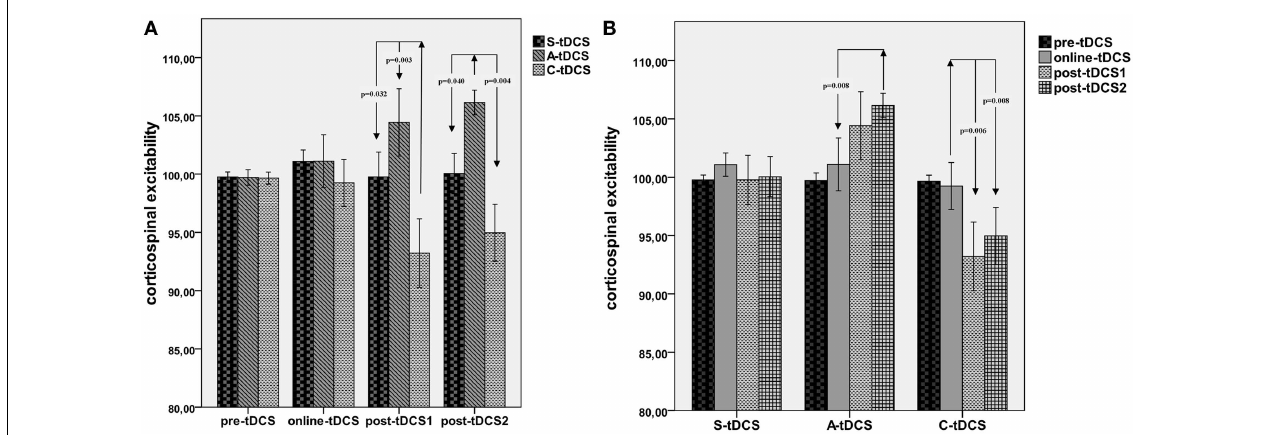
during the second 15min blocks (post-tDCS2) with respect to S-tDCS and C-tDCS. (B) Reports tDCS condition-wide corticospinal excitability values showing a significant difference between post-tDCS2 compared to online tDCS for A-tDCS, as well for post-tDCS1 and 2 with respect to online tDCS during C-tDCS. P values refer to Bonferroni corrected pairwise